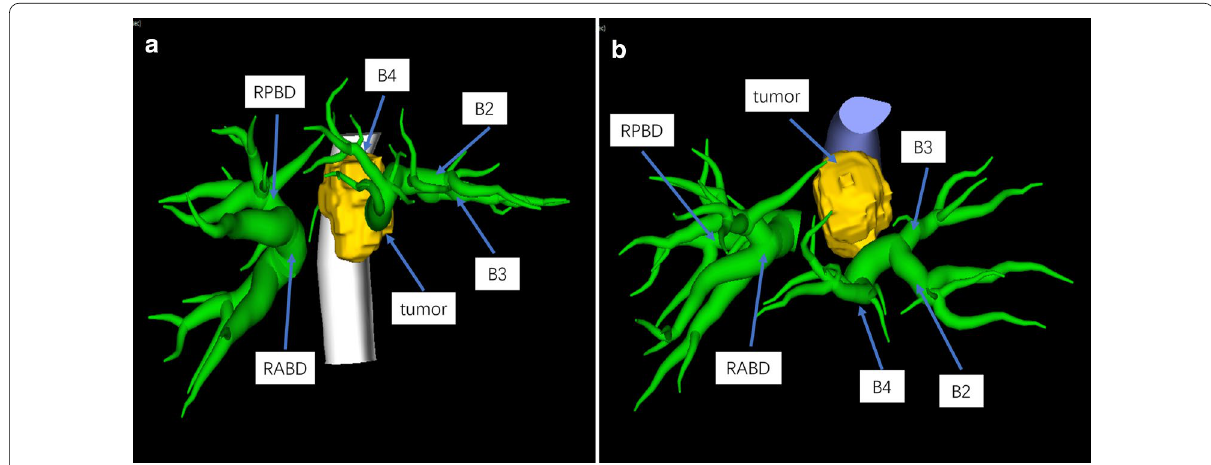
Fig. 1 Three-dimensional reconstruction of the tumor and bile duct shows the tumor was located at the hilar bile duct, and the left and right intrahepatic bile ducts were dilated. a Shows the relationships between bile duct with tumor in sagittal section. b Shows the relationships between